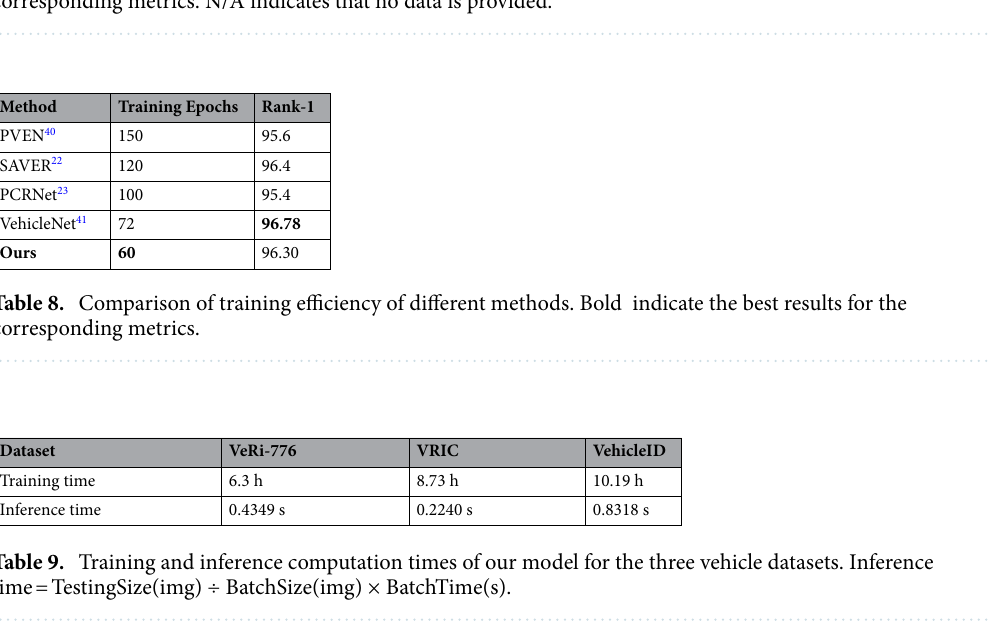
Table 7. The mAP, Rank-1, and Rank-5 on VehiceID dataset (in %). Bold indicate the best results for the corresponding metrics. N/A indicates that no data is provided.